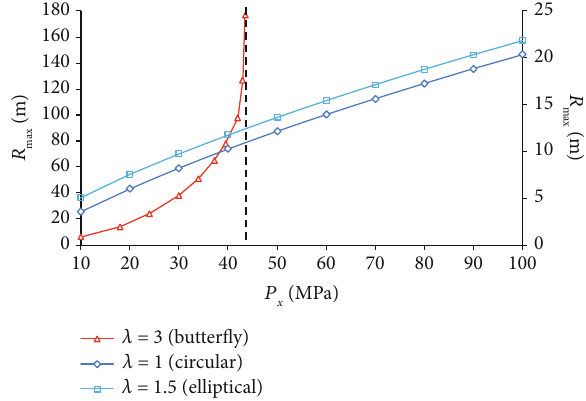
Figure 3: The relationship between the radius of the plastic zone and stress under di ff erent plastic zone